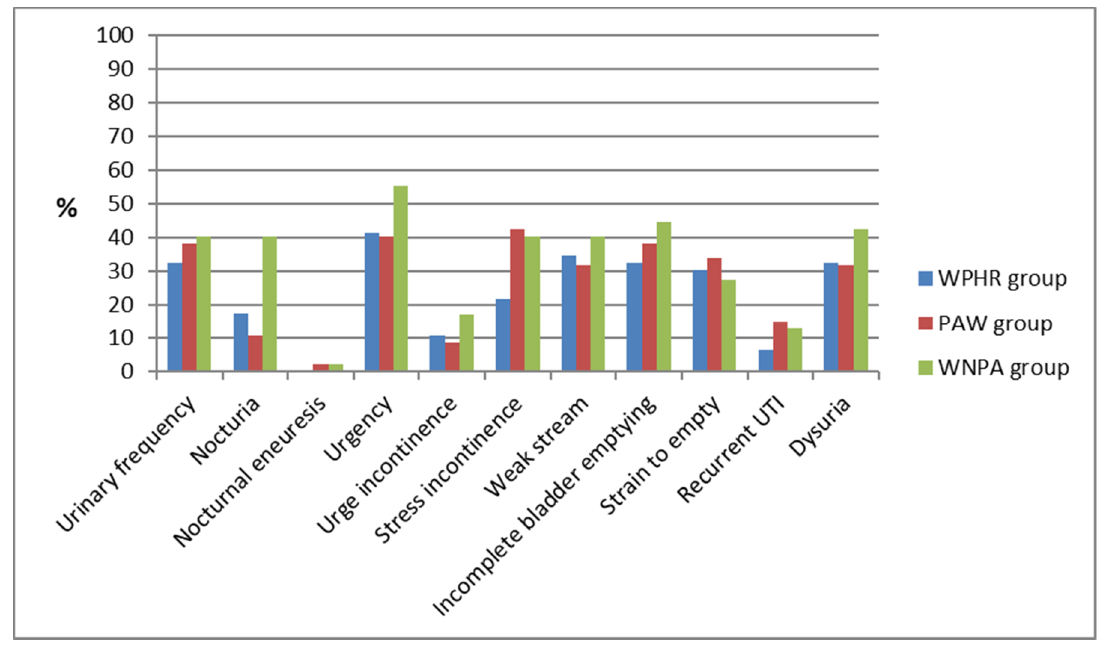
Figure 2. Occurrence of bladder symptoms by groups.